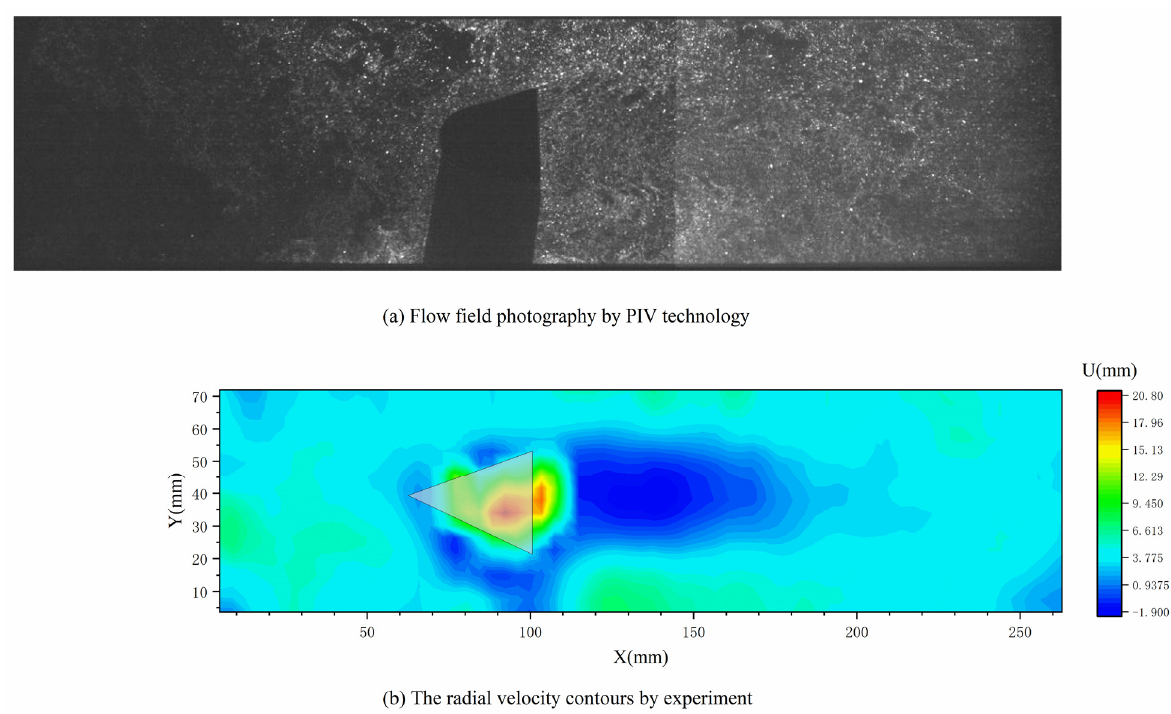
Figure 13. Flow field photography using PIV technology, and velocity contours by experiment.